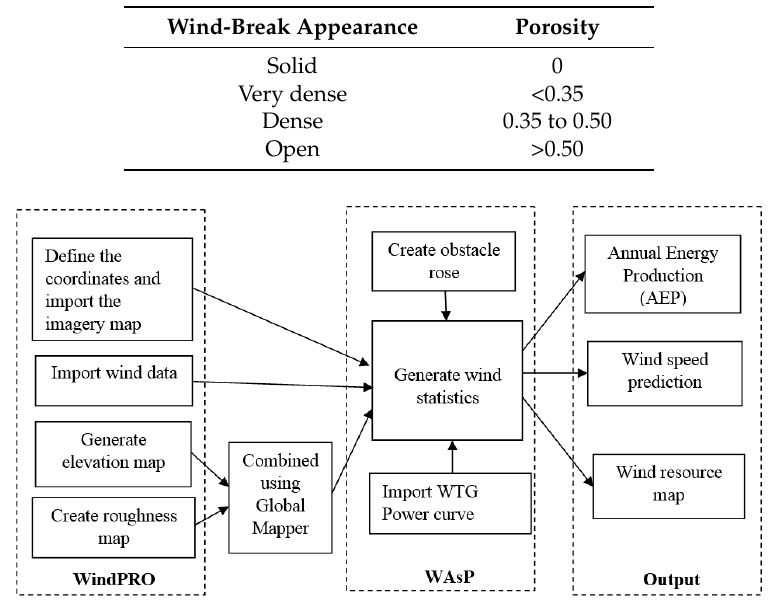
Table 3. The porosity of every obstacle [35].